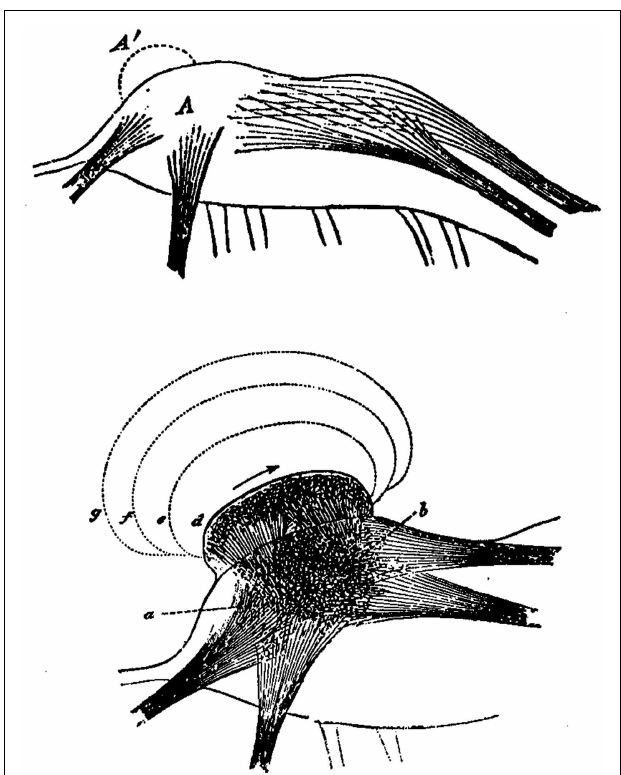
FIGURE 1 | Herbert Spencer’s concept of the evolutionary change in the nervous system by means of superimpositions (A´) of neural layers exemplified in a neural ganglion (A). Consequently, neural excitation does not proceed anymore from a to b but is rather following new neural formations ( d, e, f, g ). Image from Spencer H (The Principles of Psychology, 1896, Appleton